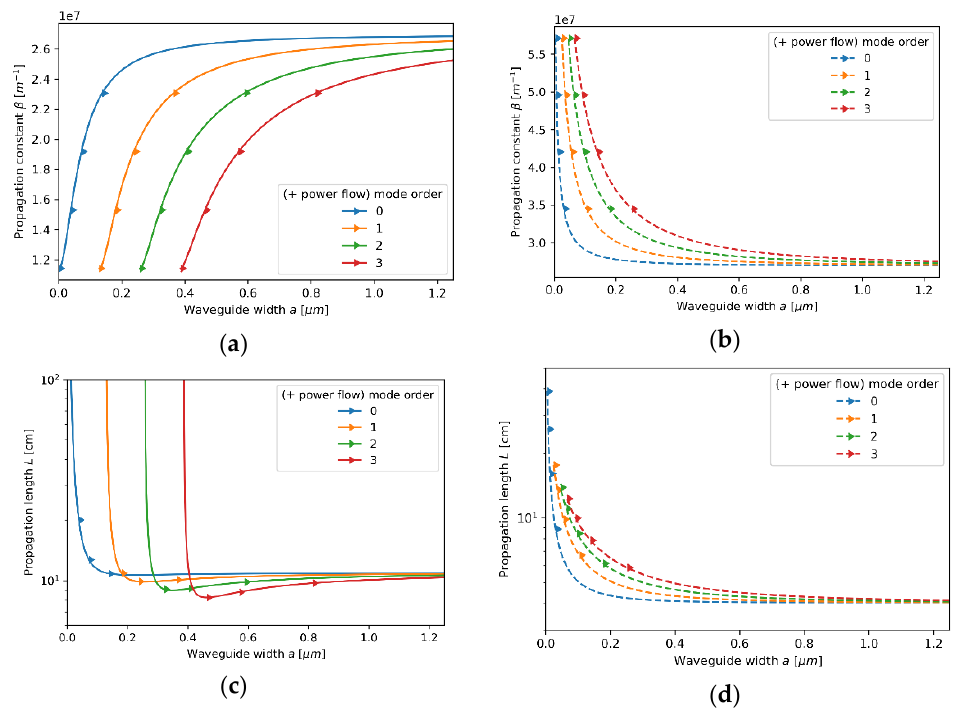
Figure 12. Propagation constant ( a , b ) and propagation length ( c , d ) of TE modes plotted versus waveguide width for an HMM waveguide with Nb2O5 layer of t Nb2O5 = 175 nm embedded in the unit cell and described with local ( a , c ) and nonlocal EMT ( b , d ).